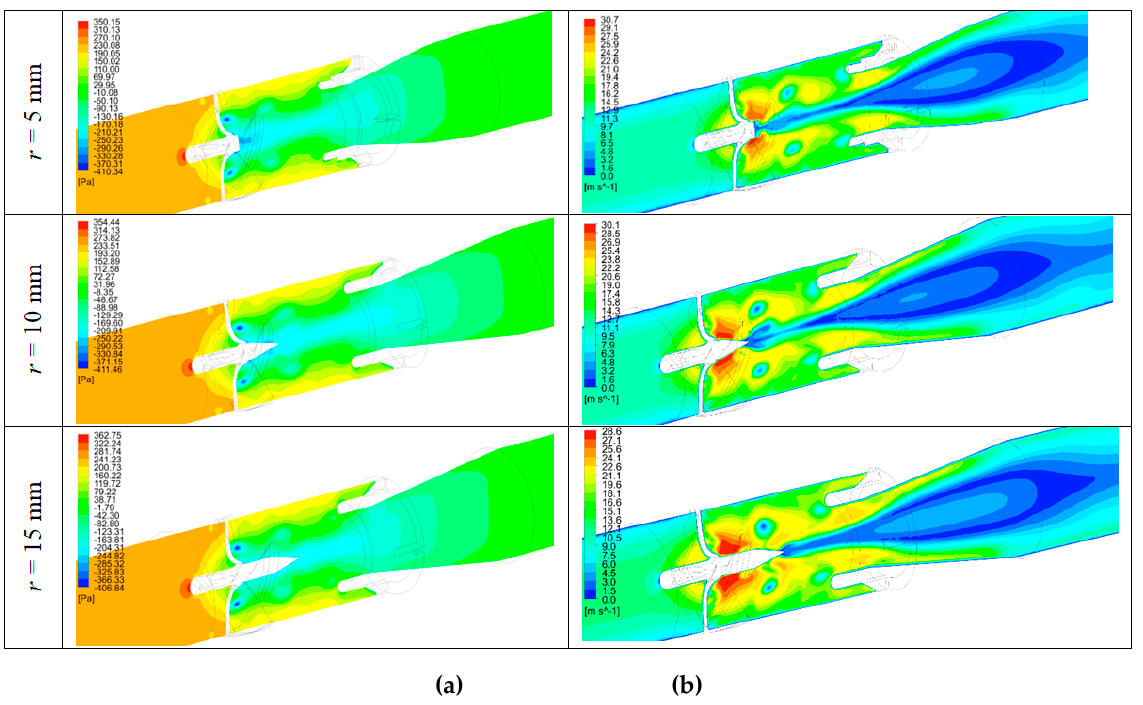
Figure 13. Pressure values ( a ) and velocity ( b ) in the cyclone after inserting the core with a cone at the outlet of the swirler-inlet velocity υ 0 = 10 m/s.